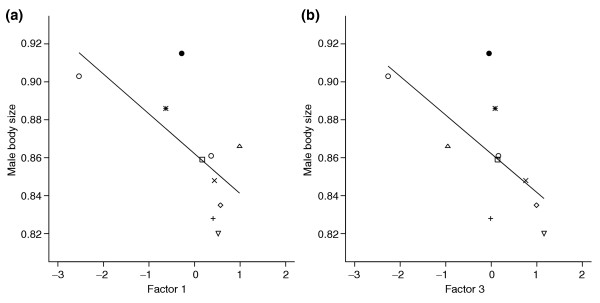
Regression plots. (a) A plot of factor 1 from candidate genes for body size on the x-axis and measured male body size on the y-axis. The solid line is the regression of factor 1 on measured male body size with an estimated slope of -0.021y with a standard deviation of 0.008 and is significantly different from zero (P = 0.04). Line crosses: open square 1136; open circle (top left), 611; open triangle 3743; plus sign, 4361; multiplication sign, 6177; open diamond, g785; inverted open triangle 8599; star 99105; solid circle, 1056; open circle (middle), 3637. (b) A plot of factor 3 from candidate genes for miRNA on the x-axis and measured male body size on the y-axis. The solid line is the regression of factor 3 on measured male body size with an estimated slope of -0.020y with a standard deviation of 0.008 and is significantly different from zero (P = 0.04). Symbols as in (a).